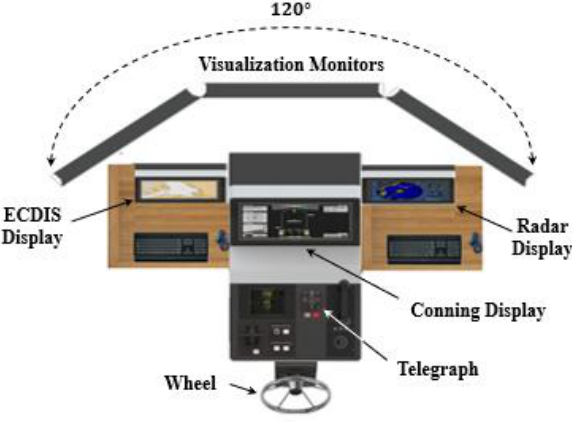
Figure 2. Experimental configuration with the Kongsberg ship-handling simulator.